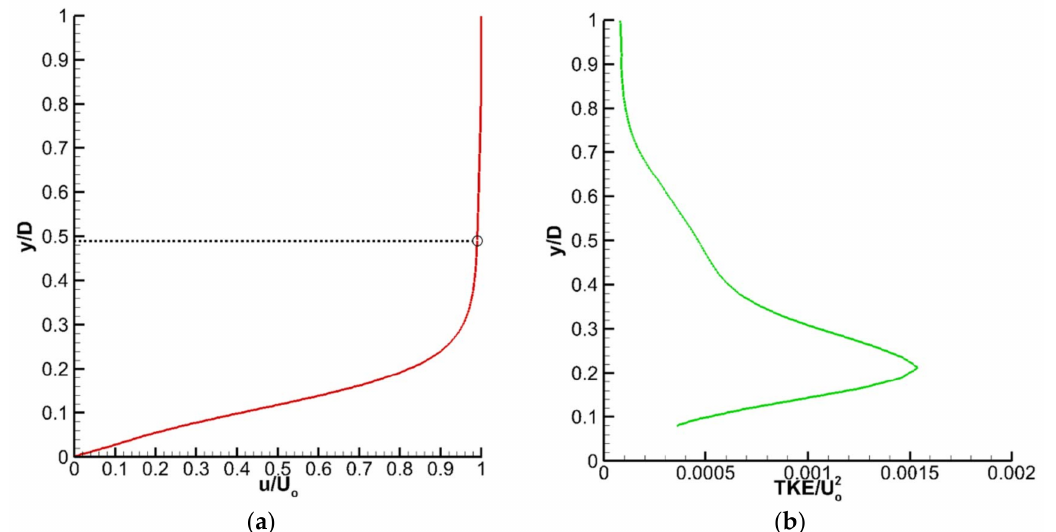
Figure 2. Inflow PIV measurement results at the symmetric plane of z = 0 cm and x/D = − 39: ( a ) dimensionless ensemble-averaged velocity, and ( b ) dimensionless turbulent kinetic energy. The dotted lines indicate the boundary layer thickness δ 0.99 Uo / D =